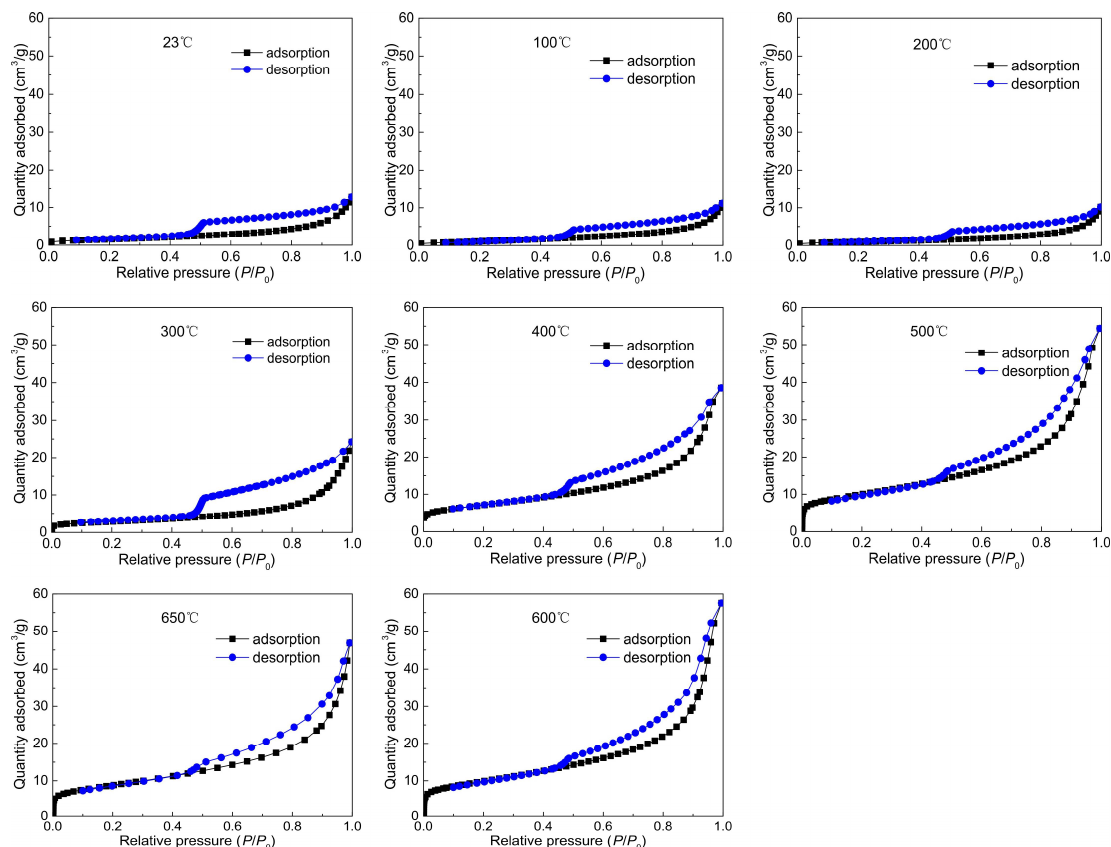
Figure 3. Adsorption–desorption isotherms of Fushun oil shale at varying temperatures.